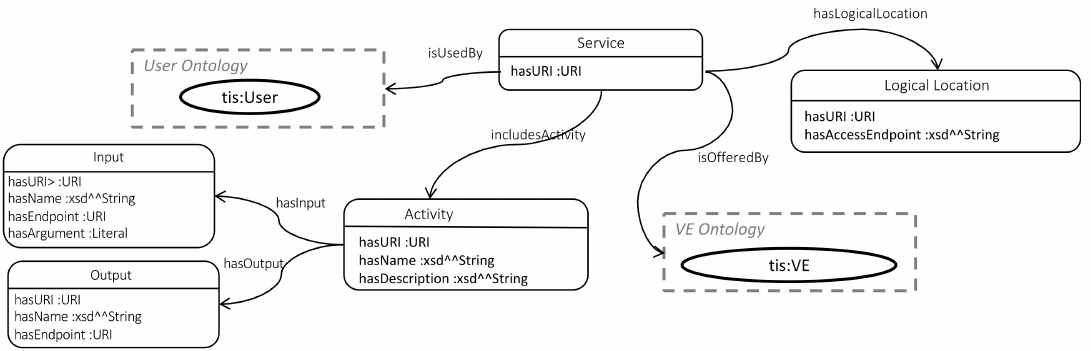
Figure 20. Service